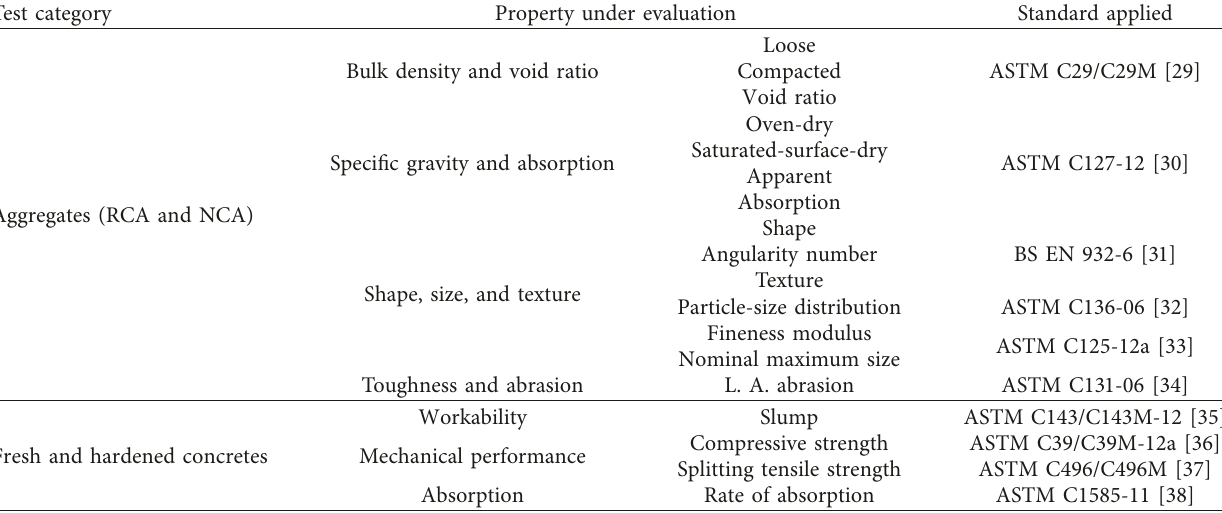
Table 2: Test methods applied to characterize the aggregate and the fresh and hardened